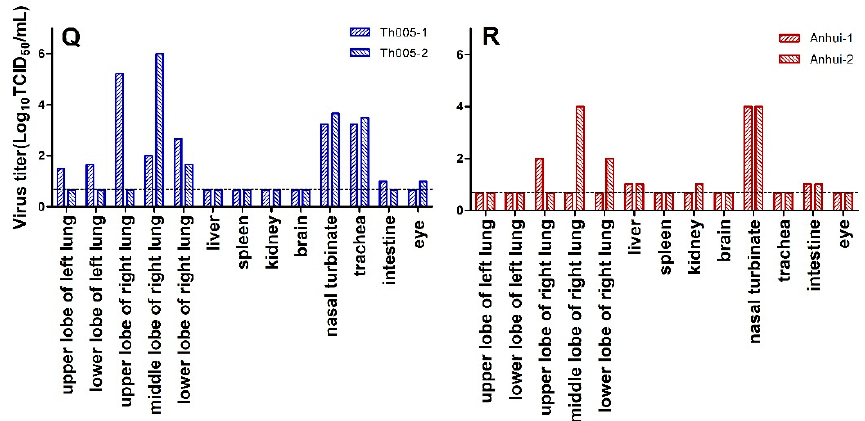
Figure 1. Replication and virulence of A/Guangdong/Th005/2017 (H7N9) and A/Anhui/1/2013 (H7N9) in ferrets and aerosol transmission experiments. Body weight: ( A ) Th005 infection group, ( B ) Th005 transmission group, ( C ) Anhui infection group, and ( D ) Anhui transmission group. Body temperature: ( E ) Th005 infection group, ( F ) Th005 transmission group, ( G ) Anhui infection group, and ( H ) Anhui transmission group. Clinical score: ( I ) Th005 infection group, ( J ) Th005 transmission group, ( K ) Anhui infection group, and ( L ) Anhui transmission group. Viral titers in ferret nasal swabs: ( M ) Th005 infection group, ( N ) Th005 transmission group, ( O ) Anhui infection group, and ( P ) Anhui transmission group. Viral titers in ferret viscera in infection groups: ( Q ) Th005 infection group and ( R ) Anhui infection group. The horizontal dotted lines are the lower limits of detection. The vertical lines indicate that two animals were euthanized and dissected on that day.